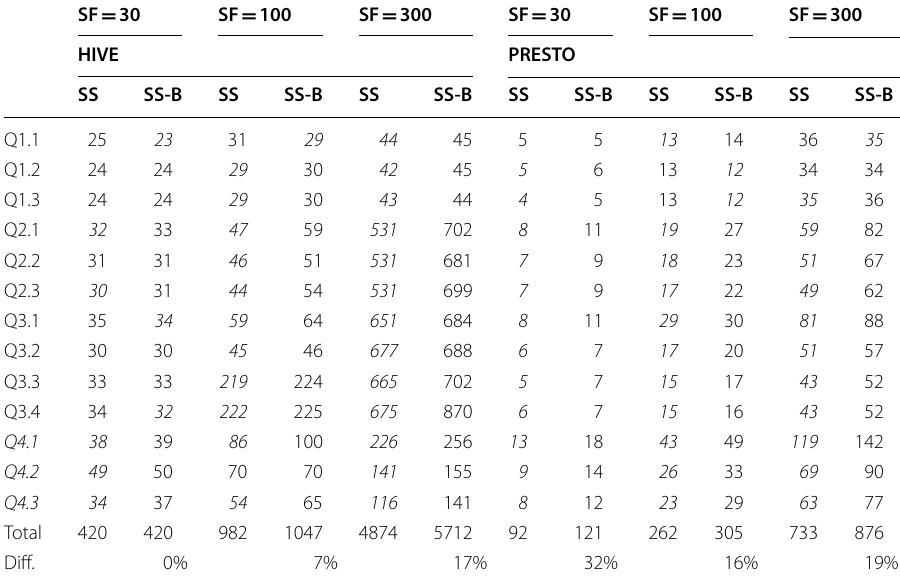
Table 7 SSB execution times: bucketing by “Orderdate”, “Custkey”, “Suppkey” and